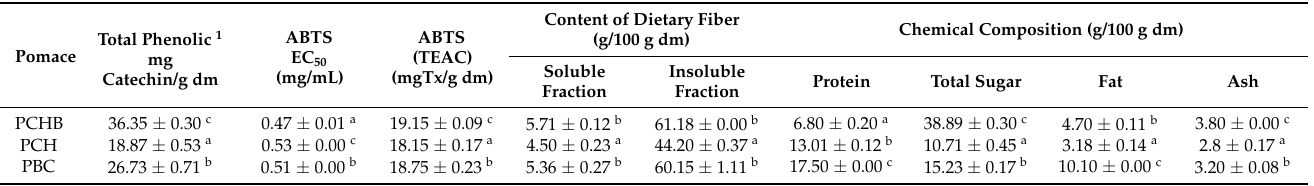
Table 1. Total phenolic, antioxidant activity, dietary fiber content, and chemical composition of fruit pomaces.